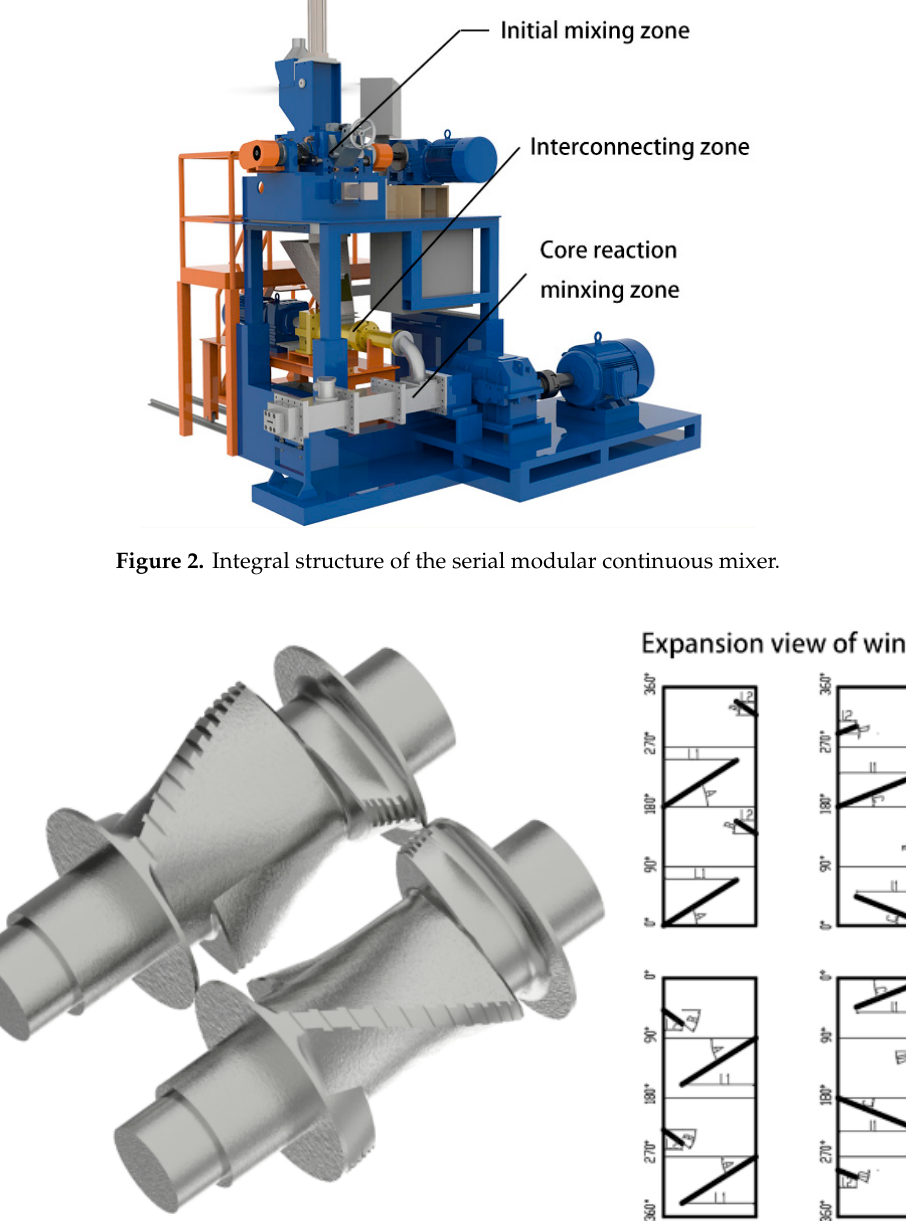
Figure 3. Structure diagram of synchronous four-wing serrated rotors.